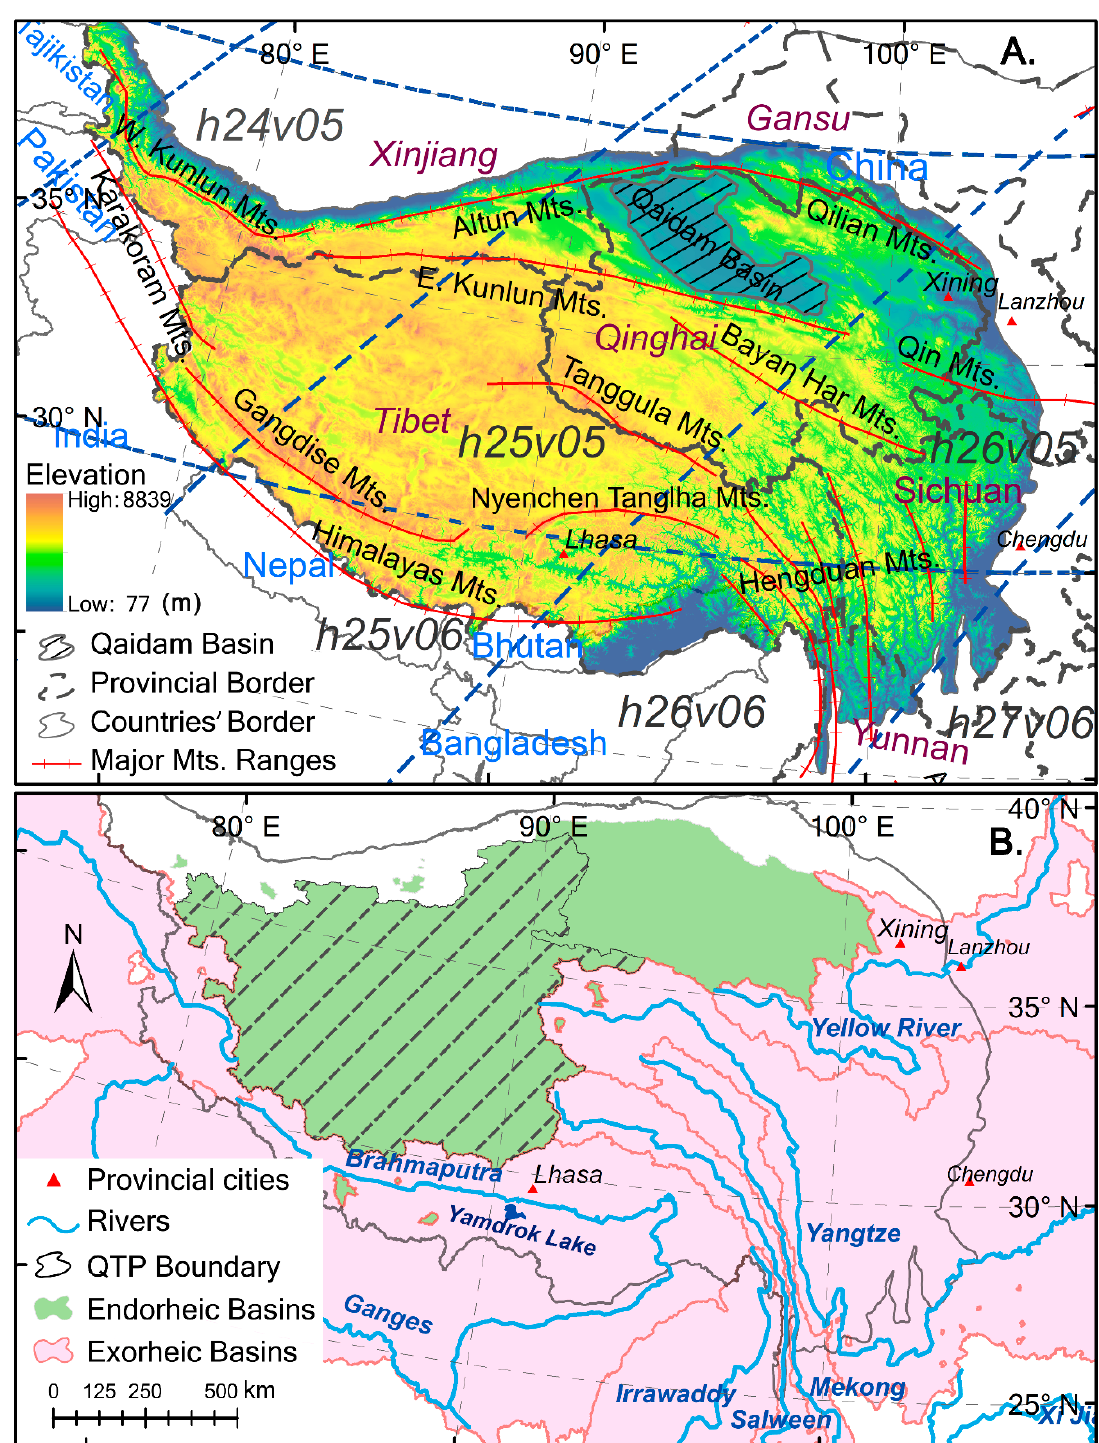
Figure 1. Study Area of Qinghai-Tibetan Plateau (QTP): ( A ) elevation, major Mts. (i.e., mountains) ranges, and provincial and country borders; ( B ) provincial cities, rivers, and the endorheic and exorheic basins. The grids, in dark blue dashed lines, overlaid are the corresponding MODIS tiles (e.g., h25v06). Boundaries of Changtang Plateau (shadowed with the dashed lines in ( B ) and the endorheic, and exorheic basins were determined from the 15-s HydroSHEDS (Hydrological data and maps based on SHuttle Elevation Derivatives at multiple Scales) drainage basin dataset [42] . Map created using ArcGIS 10.6 (ESRI, CA, www.esri.com).